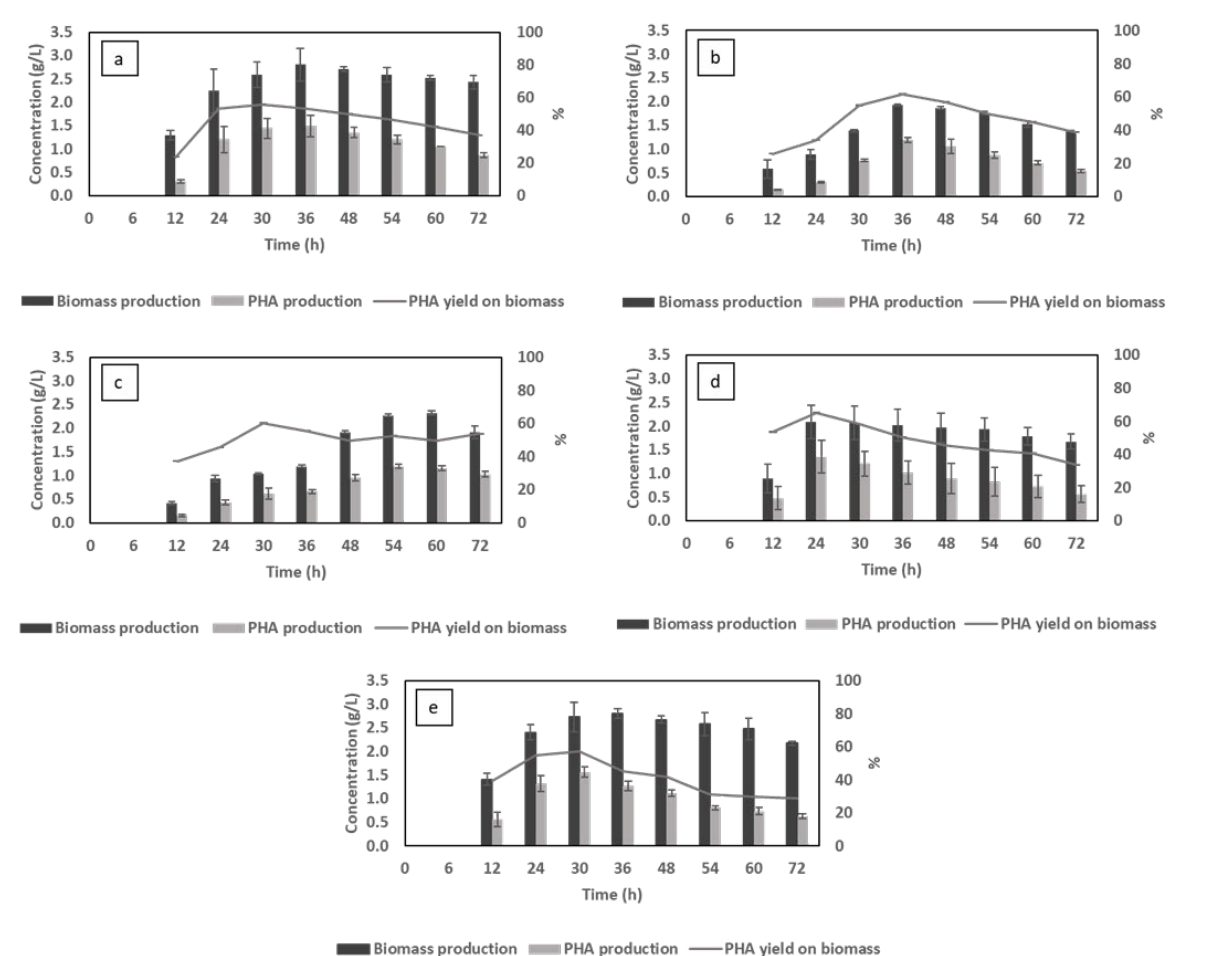
Figure 4. The effect of different cultivation factors (compared in pairs) on the changes in biomass and polyhydroxyalkanoate (PHA) production: pH control ( a ) vs. no pH control ( b ); C/N 6 ( a ) vs. C/N 12 ( c ); 1 vvm ( a ) vs. 0.25 vvm ( d ) and ammonium sulfate ( a ) vs. urea ( e ).